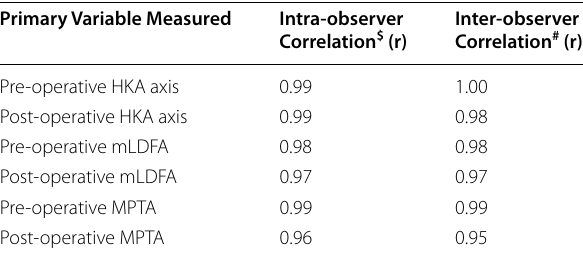
Table 4 Intra-observer and inter-observer correlation for primary variables